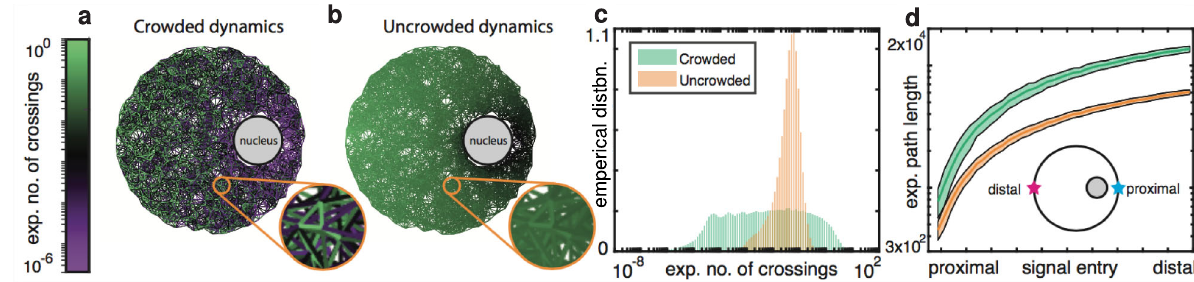
Fig. 5 The paths of tagged individuals between the cellular and nuclear membranes are heavily altered due to crowding. a and b Expected number of crossings of each narrow channel with and without crowding in a realisation of a cellular signalling network with 1000 reservoirs (Supplementary Note 4). c The normalised frequency of the number of channels for a given expected number of crossings. d Expected path length of a tagged individual as a function of the position of the initial entry at the cellular membrane. The inset describes the position of the nucleus (small circle) and the cell membrane (larger circle). The extremal entry points on the membrane are shown by the two stars. The magenta star is the distal entry point, and the cyan star is the proximal entry point. All data presented in ( c ) and ( d ) is averaged over 100 realisations of a random geometric network (Supplementary Note 4). Parameters for the discrete random walks (Supplementary Note 1) used in ( a ) – ( d ) are as follows. The number of individuals is given by N = 3 × 10 4 , α = 1, and the reservoir exit times are given by τ i = 0.1 for every reservoir